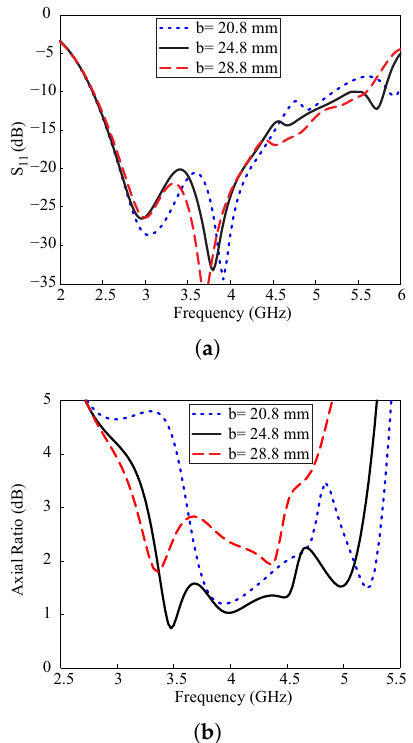
Figure 3. Effect of the variation of the dielectric resonator length b : ( a ) reflection coefficient; ( b ) axial ratio.